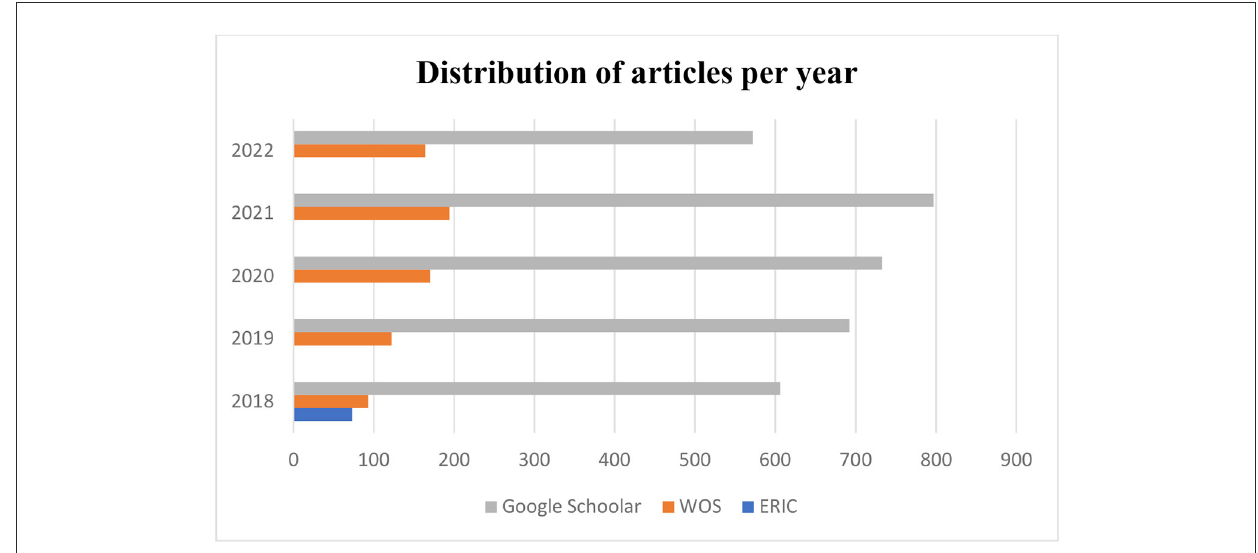
FIGURE4 Distribution of articles by year. Source: Own elaboration.